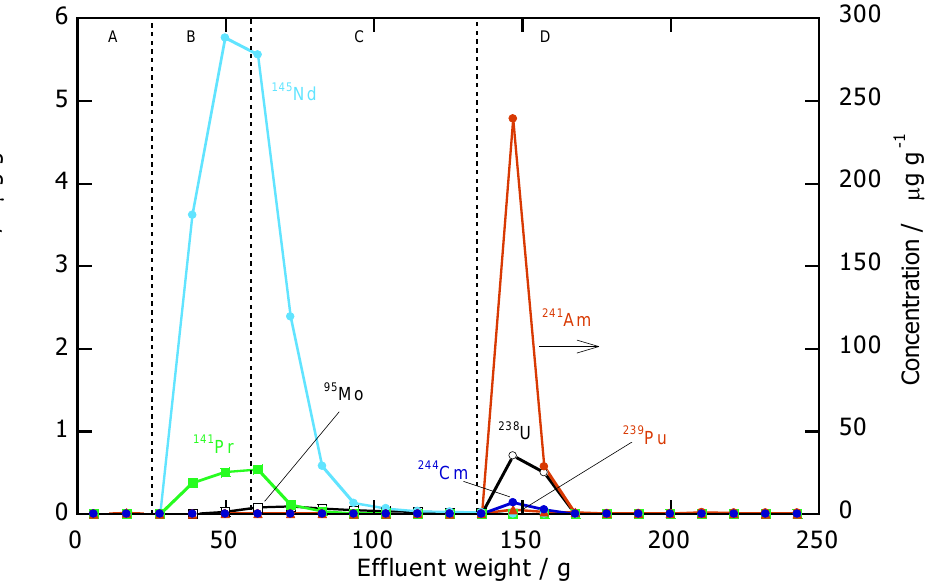
Figure 8. Separation experiment results for the genuine MA-Ln effluent by n Bu-BTP/SiO 2 -P packed column: ( A ) dead volume; ( B ) sample solution; ( C ) 0.3 M NaNO 3 ; ( D ) H 2 O.